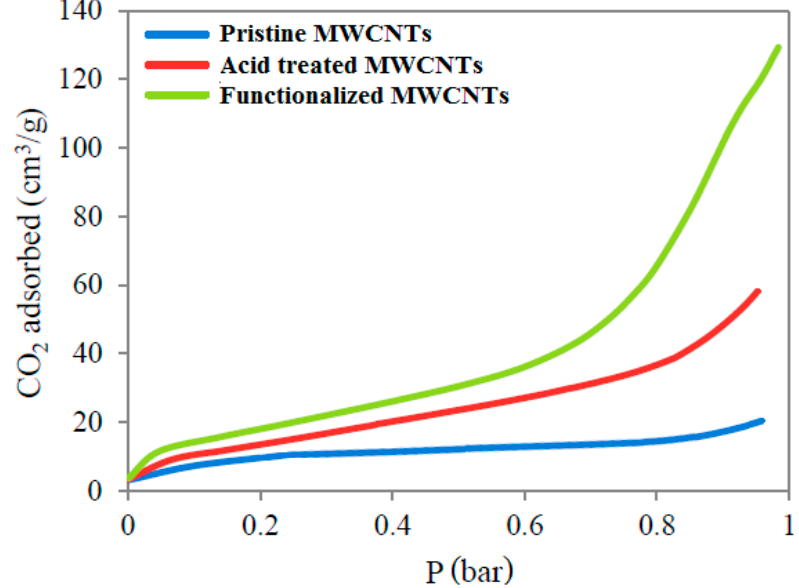
Figure 13. Adsorption breakthrough curves of pristine MWCNTs, acid treated MWCNTs, and amine functionalized MWCNTs.